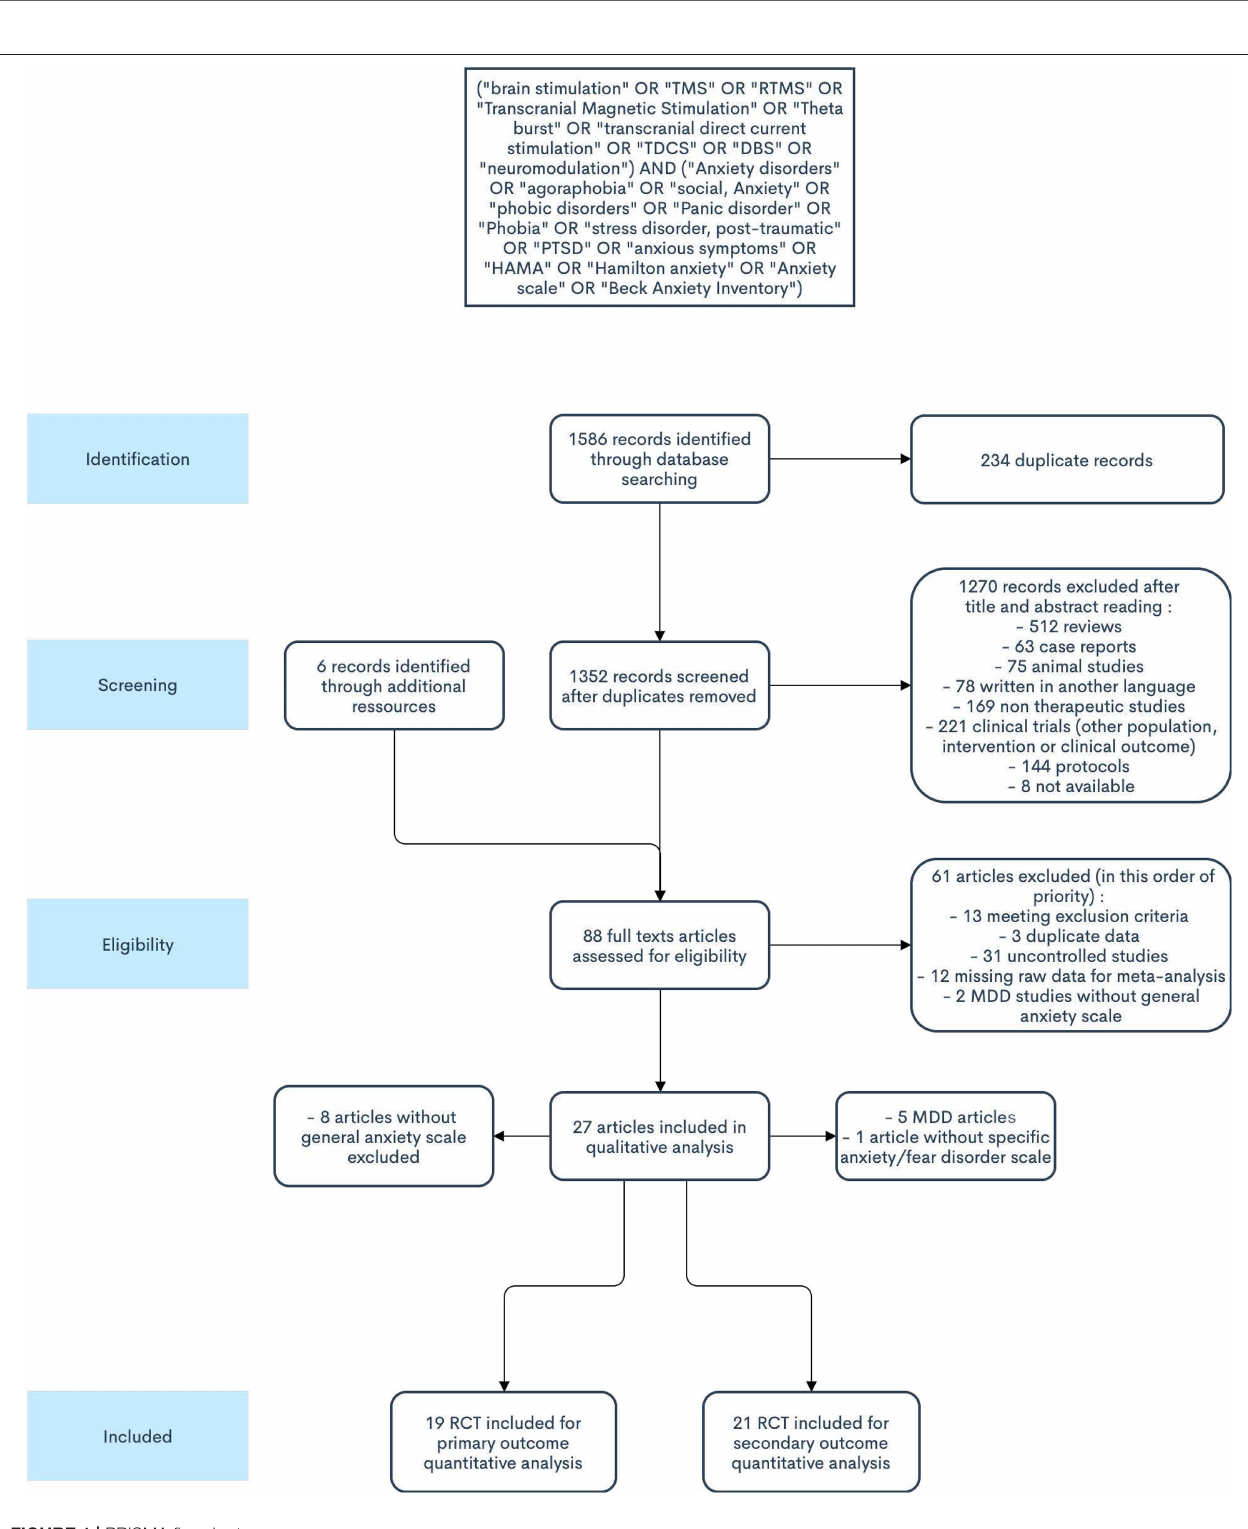
FIGURE 1 | PRISMA